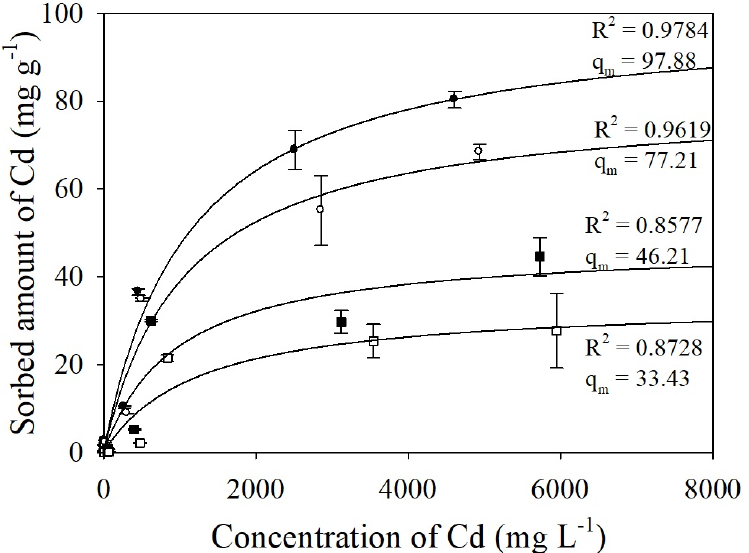
Figure 2. Equilibrium isotherms of cadmium adsorption by spent coffee grounds under different background electrolyte concentrations of 0 ( ● ), 2 ( ○ ), 20 ( ■ ), and 200 ( □ )